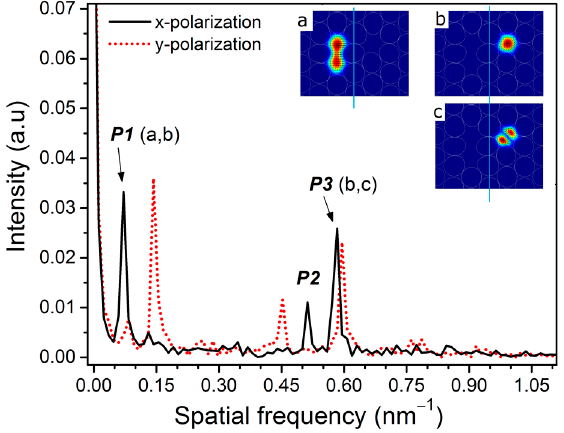
Figure 3. Frequency spectrum of the fiber m-MZI using highly birefringent ATC-PCF ( L ~ 3.6 cm) for two polarizations. Inset shows the electric-field patterns of ( a ) the core mode of the large core, and ( b , c ) the two lower-order LP modes of the small core in the ATC-PCF for a fixed polarization state of input light.